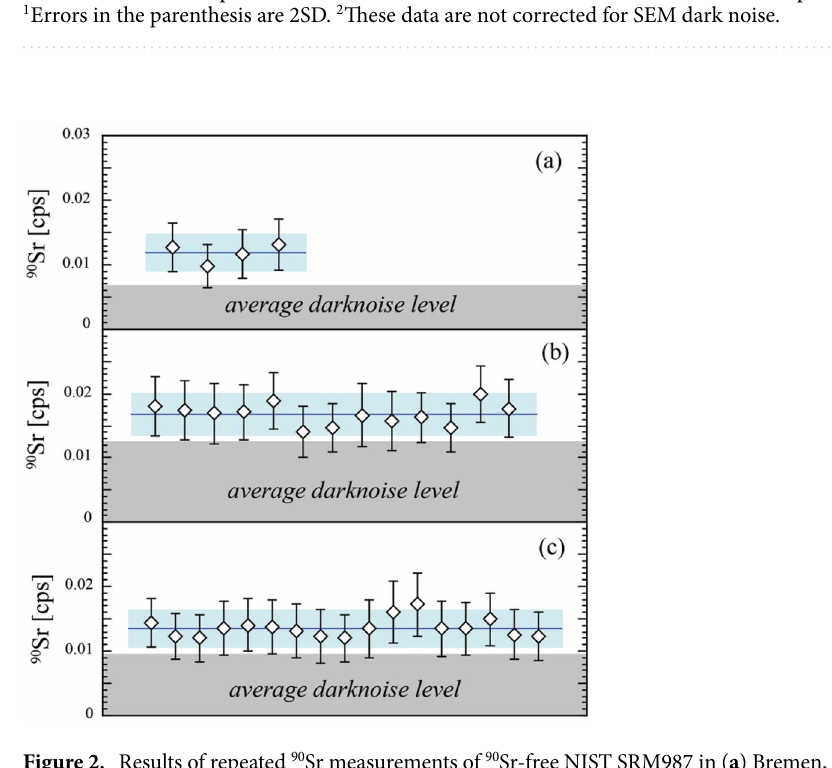
Figure 2. Results of repeated 90 Sr measurements of 90 Sr-free NIST SRM987 in ( a ) Bremen, ( b ) Fukushima-1, and ( c ) Fukushima-2 sessions. White diamonds represent noise uncorrected data of a single measurement. Blue line and blue bands represent the average and 2 SD range of the multiple measurements. The grey area represents the average intensity of dark noise observed during each measurement